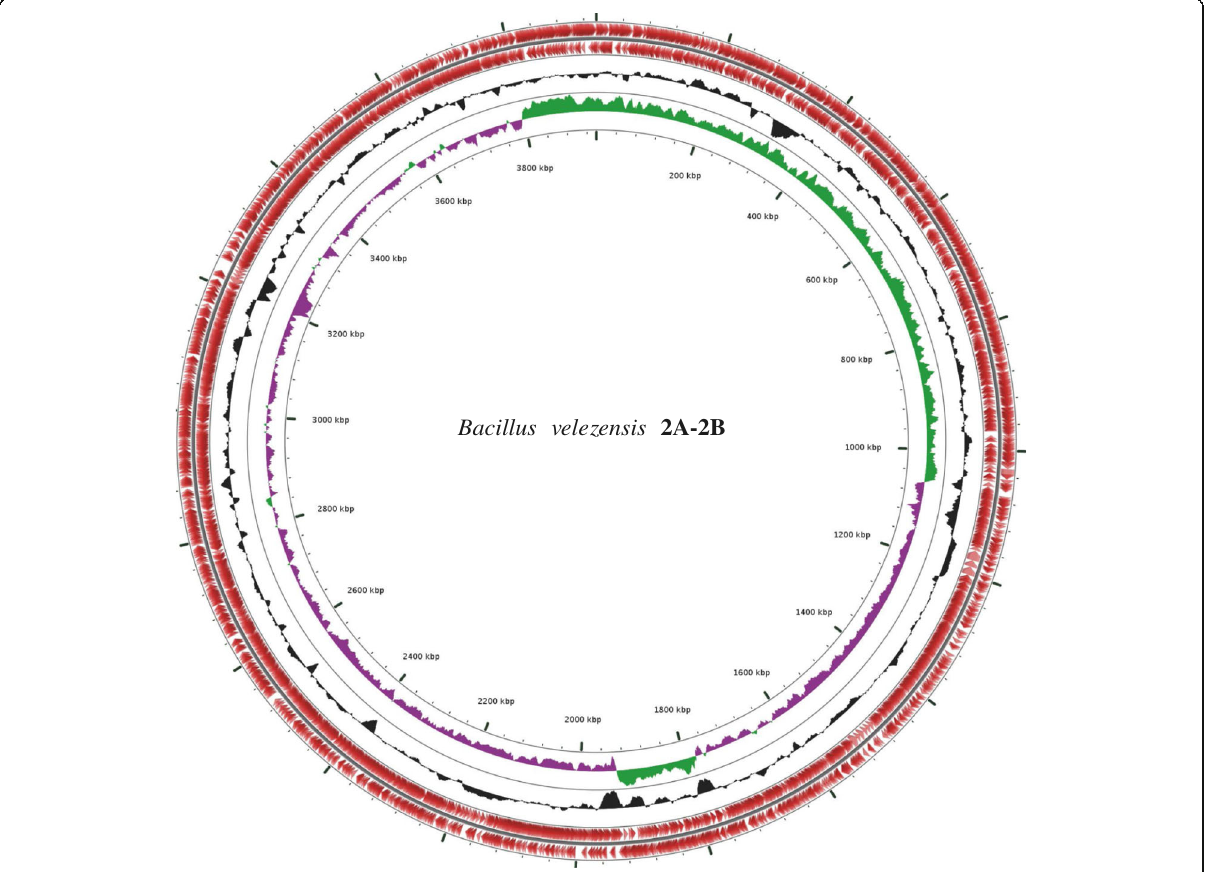
Fig. 5 Circular map of the chromosome of Bacillus velezensis 2A-2B obtained with CGView comparative genomics tool [26]. From inner to outer rings: ring 1 scale marked in every 200 kbp, ring 2 GC skew (green +, purple -), ring 3 GC% content, ring 4 CDSs on reverse strand and ring 5 CDSs on forward